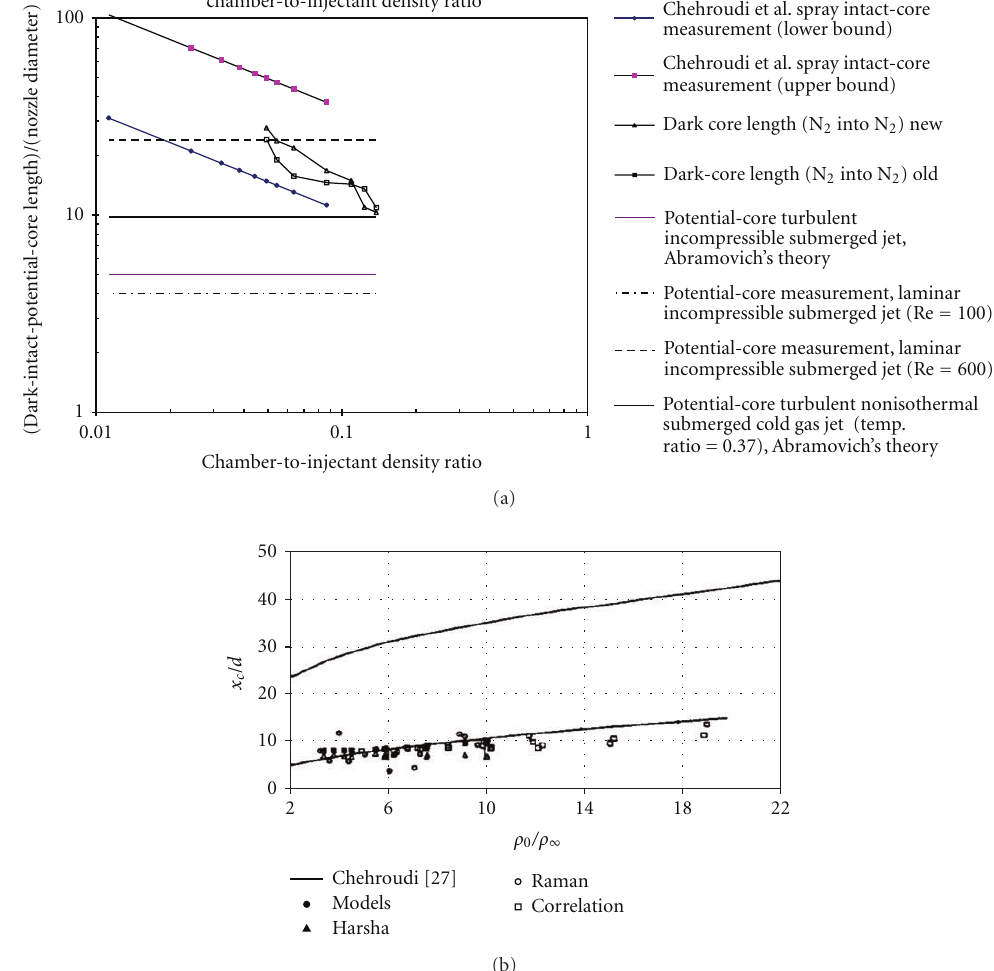
Figure 9: Ratio of either the dark-core, intact-core, or potential-core length, depending on the case, divided by the density ratio for single jets. (a): Chehroudi et al. [10], determined by analysis of shadowgraphs, for an injector L/D = 200. (b): Branam and Mayer [13], determined via Raman data, injector L/D = 40. Models: determined by computer simulation. Correlation: a correlation using a set of Raman’s data by Branam and Mayer